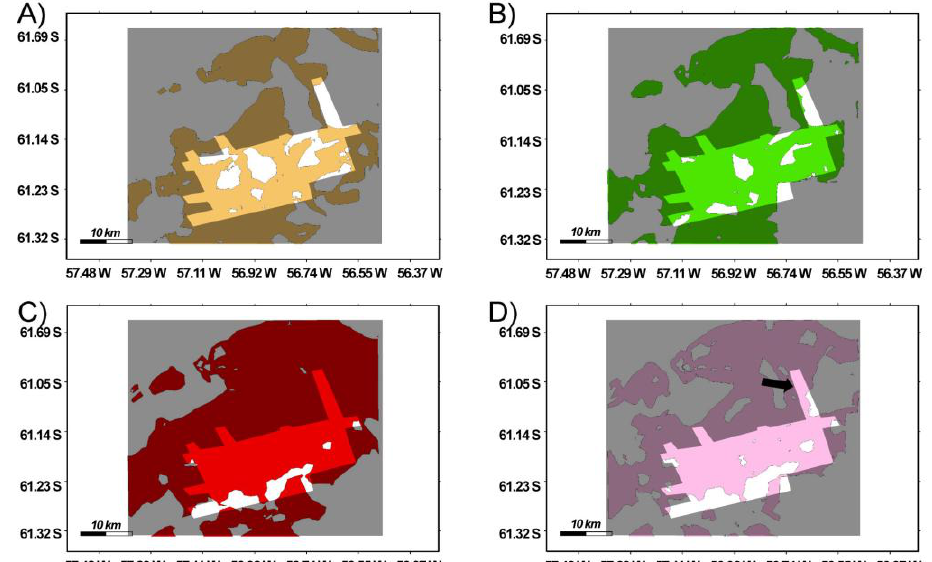
Figure 9. Map of the difference between seismic and calculated BSR depth produced by using the GIS software; see text for details. geothermal gradient equal to ( A ) 32.5 °C/km, to ( B ) 35 °C/km, to ( C ) 37.5 °C/km and to ( D ) 40 °C/km. The mask limits the central area. Black arrows indicate the Mud Volcano